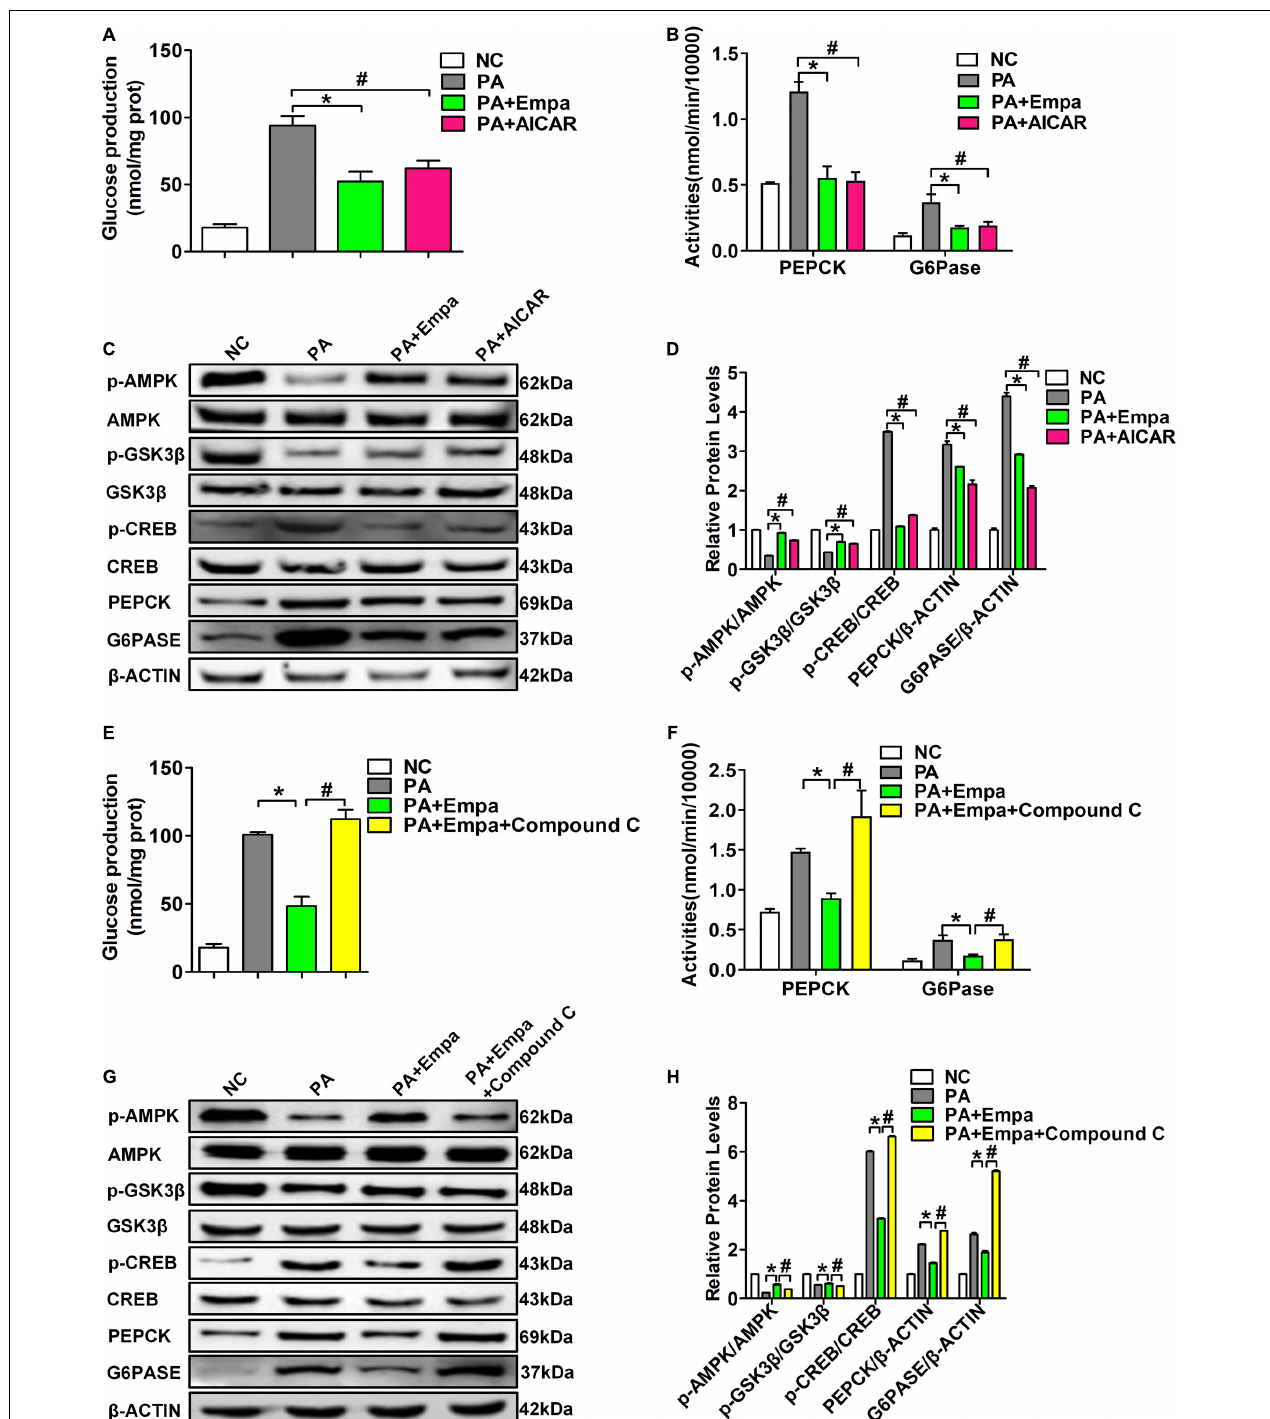
FIGURE 4 | 5-Aminoimidazole-4-carboxamide1-b-D-ribofuranoside (AIACR) and compound C could regulate the AMPK signalling pathway under empagliflozin treatment in vitro . HL7702 cells were treated with the AMPK agonist AICAR and empagliflozin and PA. (A) Glucose production levels ( n = 3 samples/group). (B) PEPCK and G6Pase activities ( n = 3 samples/group). (C) Relative protein expression levels of p-AMPK, AMPK, p-GSK3 β , GSK3 β , p-CREB, CREB, PEPCK, and G6PASE were determined by western blotting. (D) Protein quantitative statistics ( n = 3 samples/group). * P < 0.05, PA vs. PA+Empa; # P < 0.05, PA vs. PA+AIACR. HL7702 cells were treated with the AMPK inhibitor compound C and empagliflozin and PA. (E) Glucose production levels ( n = 3 samples/group). (F) PEPCK and G6Pase activities ( n = 3 samples/group). (G) Relative protein expression levels of p-AMPK, AMPK, p-GSK3 β , GSK3 β , p-CREB, CREB, PEPCK, and G6PASE were determined by western blotting. (H) Protein quantitative statistics ( n = 3 samples/group). * P < 0.05, PA vs. PA+Empa; # P < 0.05, PA+Empa vs. PA+Empa+Compound C.